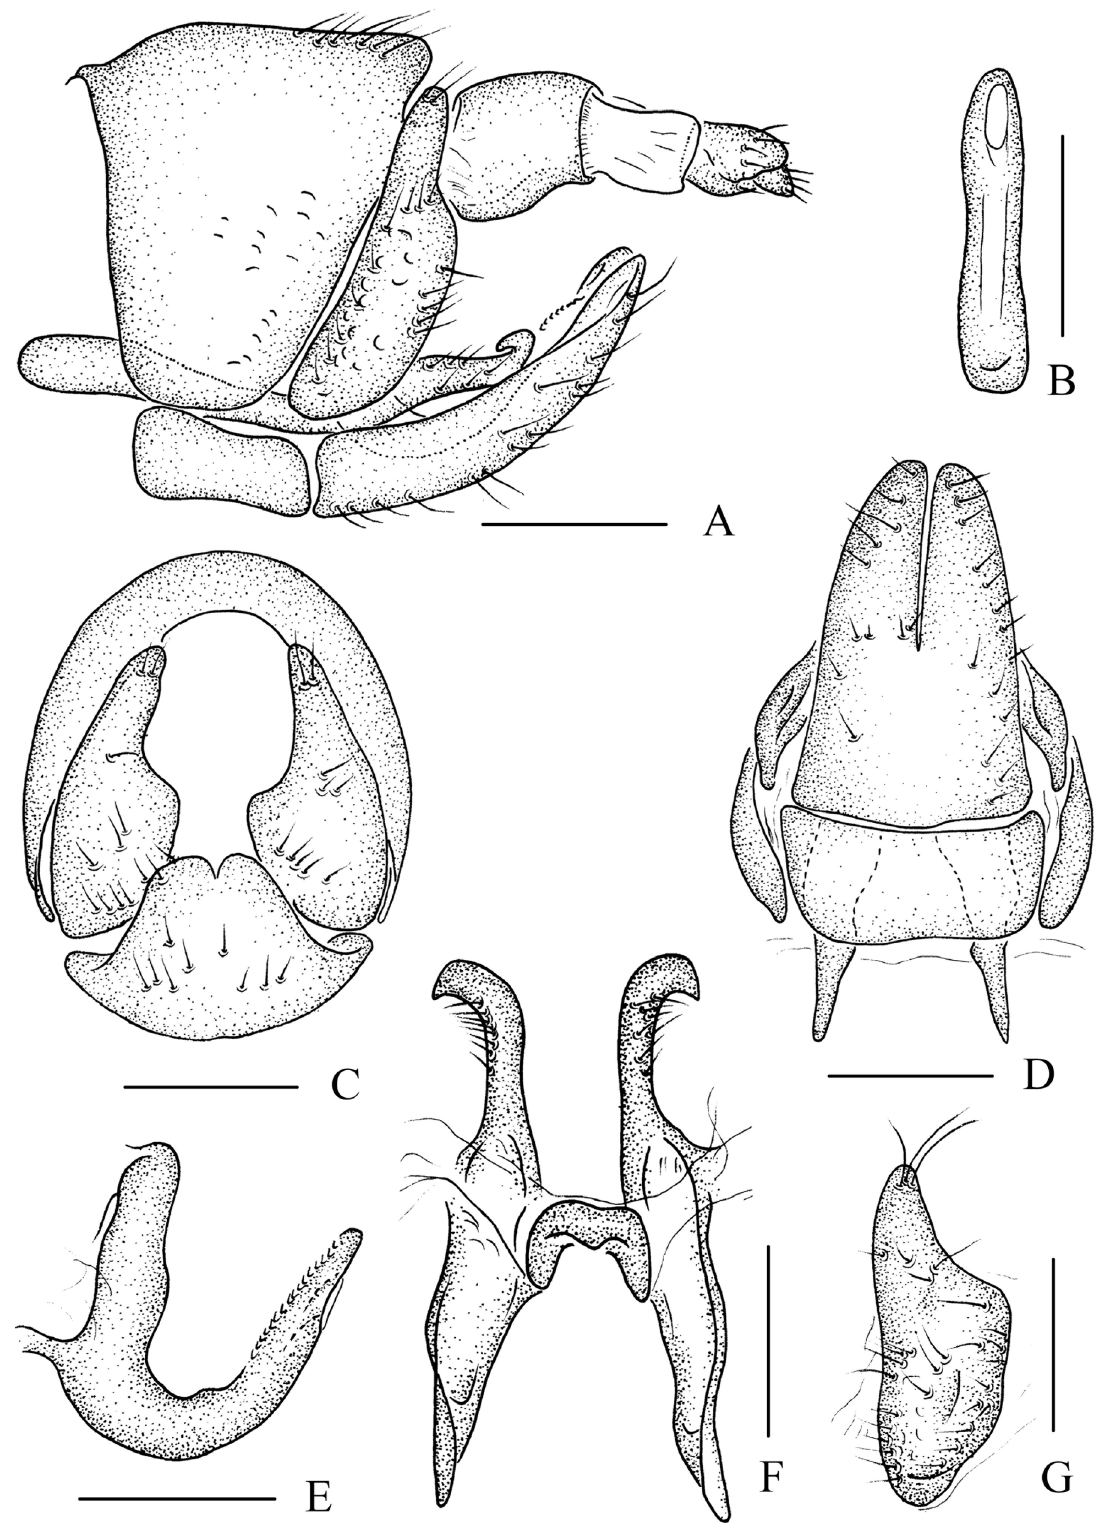
Fig. 3. Machaerotypus stigmosus Li & Chen sp. nov., paratype, ♂ (IEGU). A, C, D . Genitalia in lateral, posterior and ventral view. B, E . Aedeagus, posterior and lateral view. F . Style, dorsal view. G . Lateral plate. Scale bars = 0.2